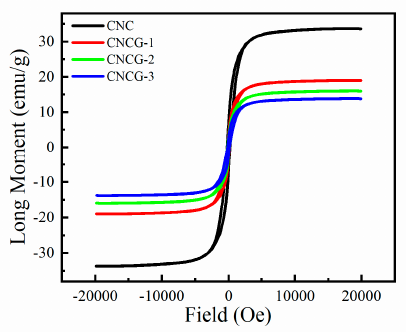
Figure 4. The room-temperature hysteresis loops of all composites.